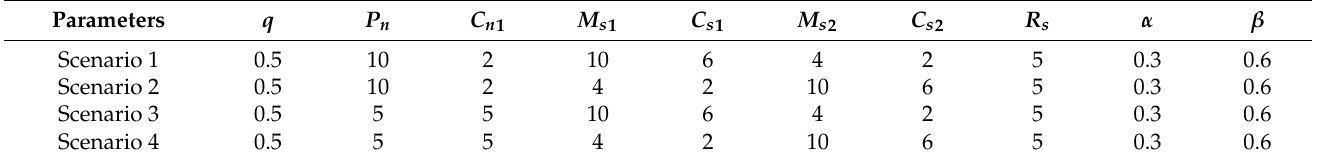
Table 7. The simulation parameters between local government and coal-related